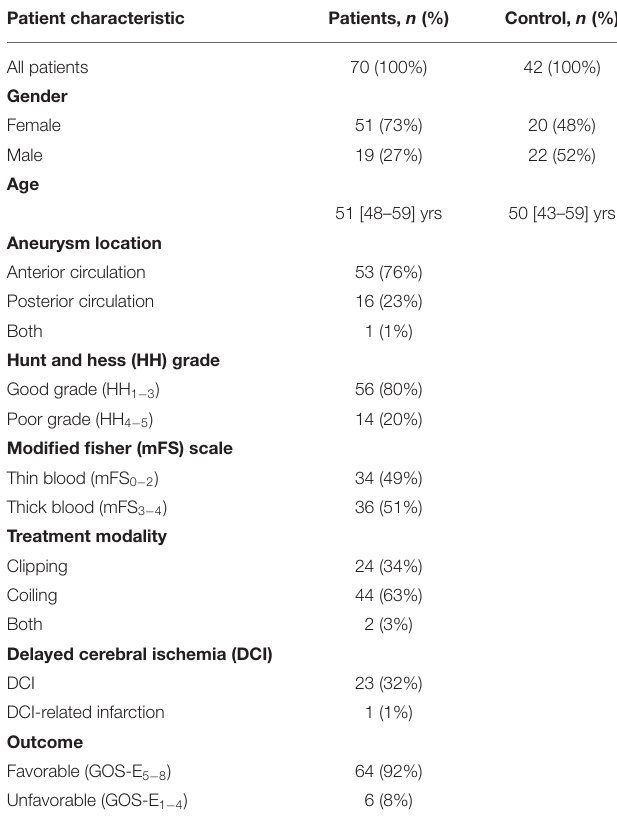
TABLE 1 | Demographic and clinical data of control and aSAH